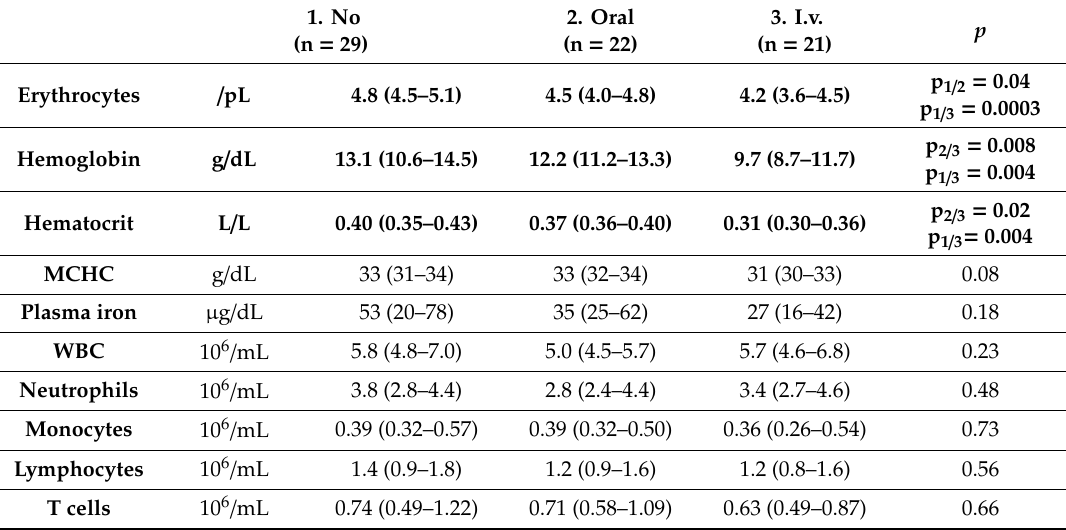
Table 4. Characteristics of HHT patients in relation to the type of iron-replacing